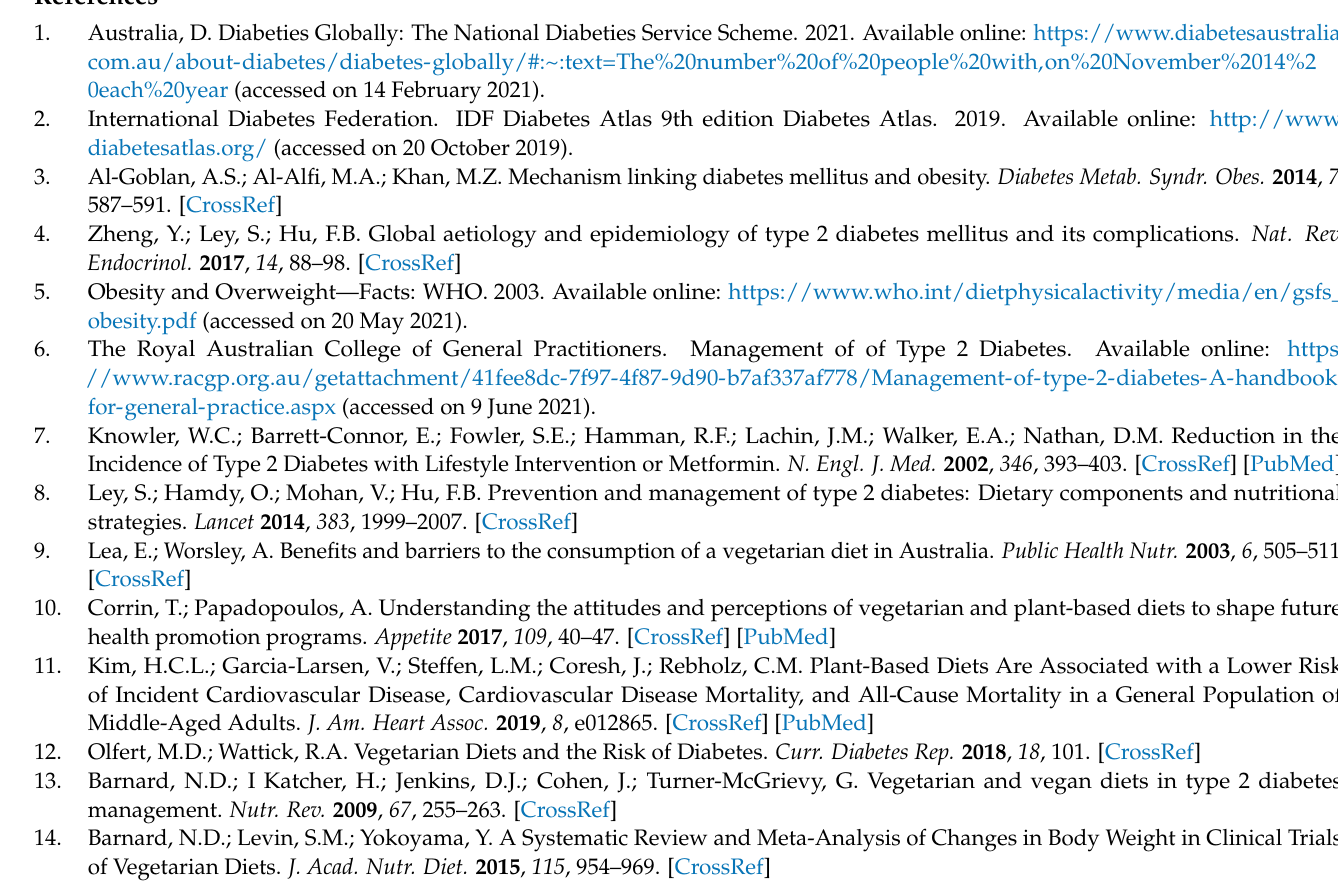
PRISMA 2020 Checklist. Figure S1: Funnel plot illustrating publication bias in the studies reporting the effect of PBD on body weight (A) and BMI (B). Figure S2: Leave-one-out sensitivity analysis for body weight (A) and BMI (B). Figure S3: Subgroup analysis for the impact of PBD type on BMI (kg/m 2